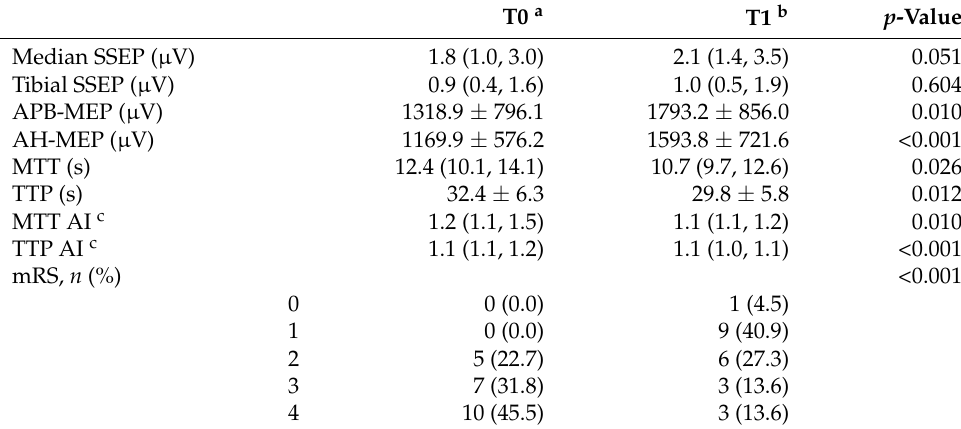
Table 3. Changes in examined parameters in the MB group.